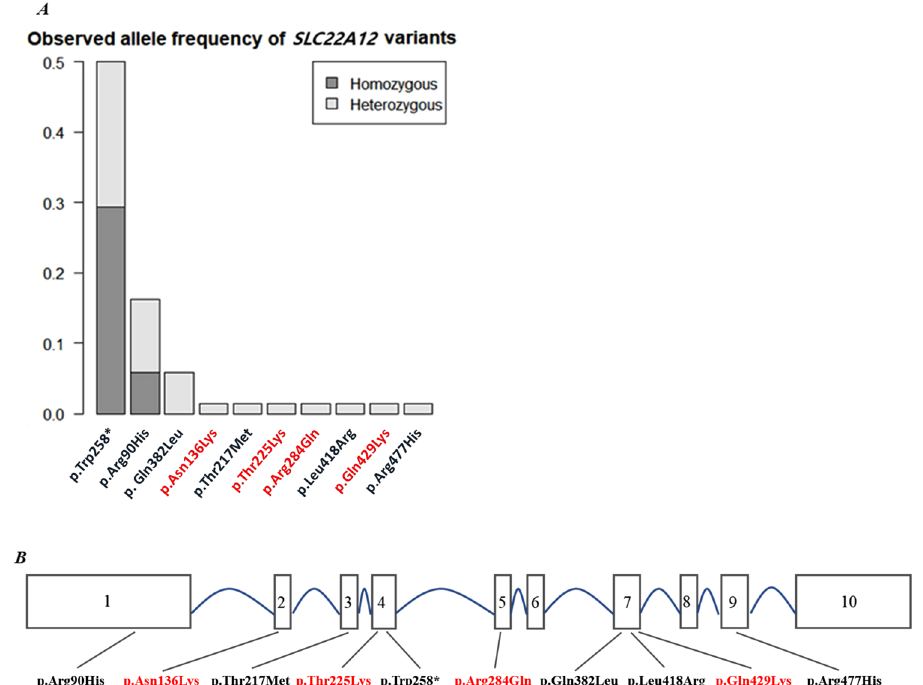
Figure 2. ( A ) Allele frequency distribution in SLC22A12 variants from KoGES cohorts (n = 31). ( B ) A schematic diagram of the exonic location of SLC22A12 variants found in 27 subjects. Newly discovered coding variants are marked in